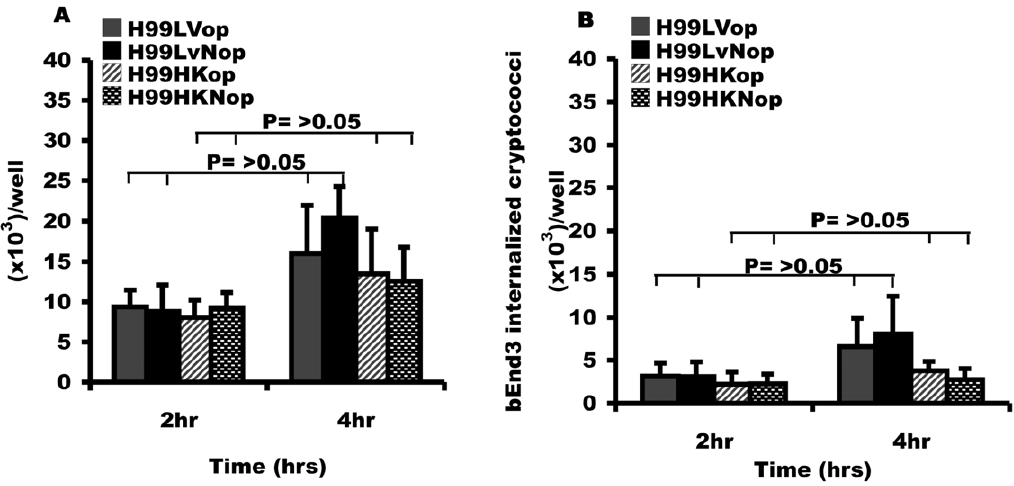
Figure 2. Effect of opsonisation on cryptococcal binding and uptake by bEnd3 cells. Live (LV) and heat-killed (HK) H99 cryptococci were opsonised with mouse derived anti-capsule IgG antibody, 18B7 and the rate of adherence and internalization was determined by fluorescence microscopy. (A) Association of opsonised (op) and non-opsonised (Nop) cryptococci with bEnd3 cells. Rate of association of opsonised and non- opsonised H99LV cryptococci was similar, P=0.8 and 0.4 at 2 hr and 4 hr respectively. Similarly, there was no difference between opsonised and non- opsonised heat-killed H99 cryptococci, P=0.9 and 0.5 at 2 hr and 4 hr respectively. (B) Rate of internalization of opsonised and non-opsonised cryptococci internalized by bEnd3 cells. The number of internalized H99LV cryptococci was similar, regardless of opsonisation status (P=0.9 at both 2 hr and 4 hr). Similarly, there was no difference between opsonised and non-opsonised heat-killed H99 cryptococci, P=0.5 and 0.4 at 2 hr and 4 hr respectively. Error bars are standard error of the mean, n=5